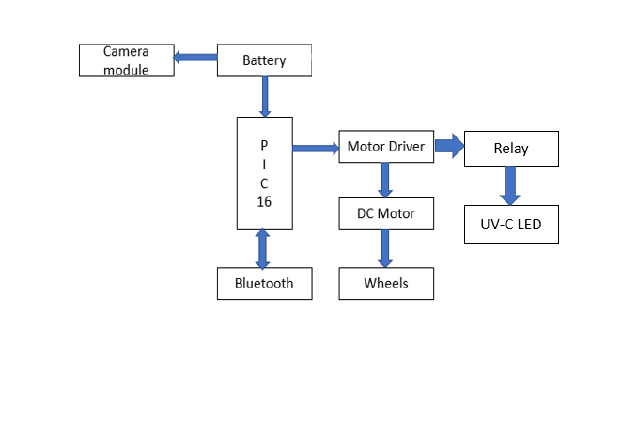
Fig. 1. Block Diagram of Proposed